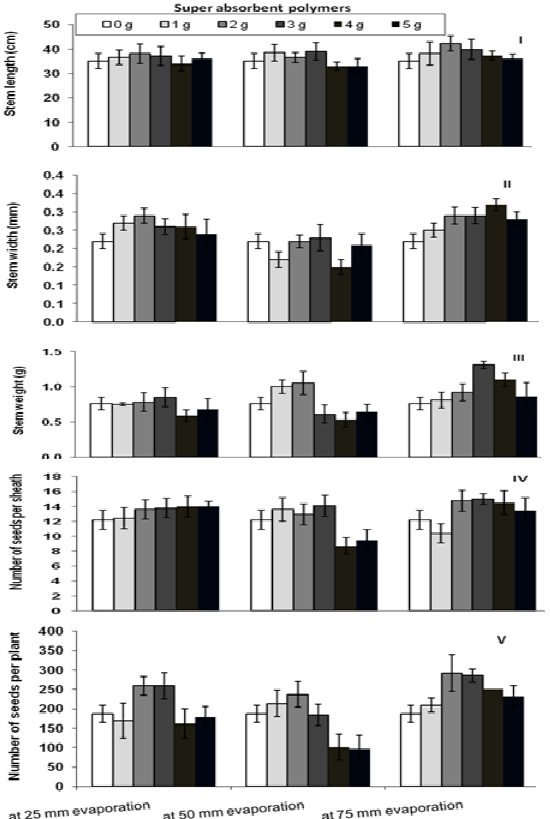
Fig. 2. Means comparisons of stem length (I), stem width (II),